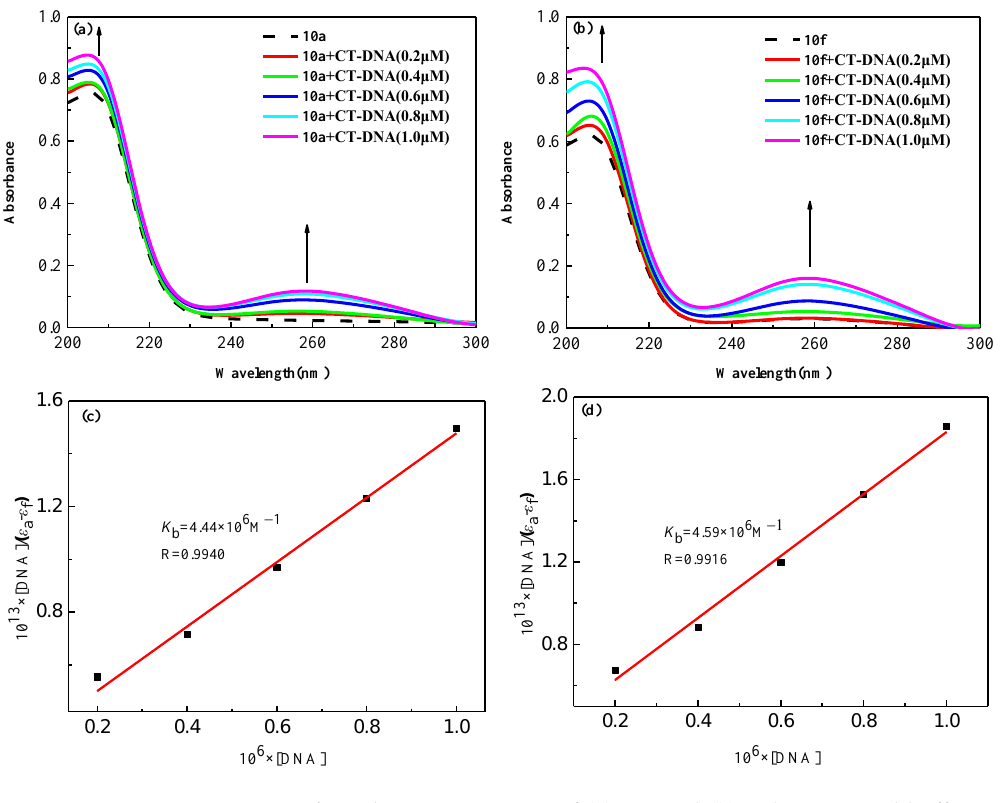
Figure 6. UV/Vis absorption spectra of ( a ) 10a and ( b ) 10f in Tris-HCl buffer upon addition of CT-DNA. Plots of [DNA]/( ε a − ε f ) versus [DNA] for the titration of CT-DNA with ( c ) 10a and ( d ) 10f .